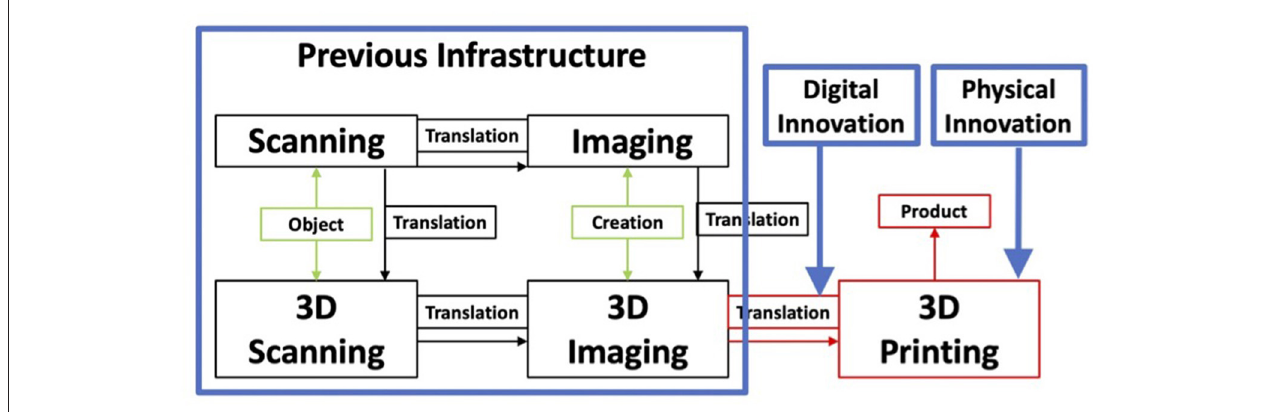
FIGURE 1 | 3D printing as development of its predecessors, and segmentation according to observations by Polykarpou et al.